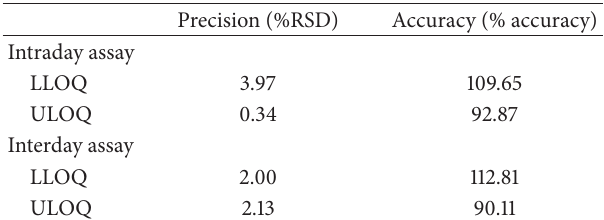
Table 3: Precision and accuracy of LLOQ and